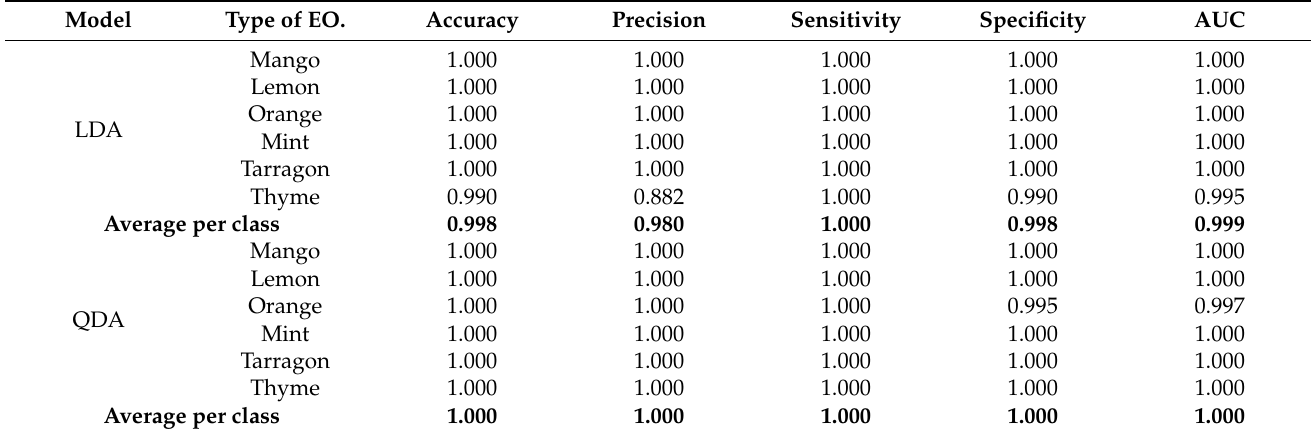
Table 4. Performance parameters of LDA and QDA models for six-group